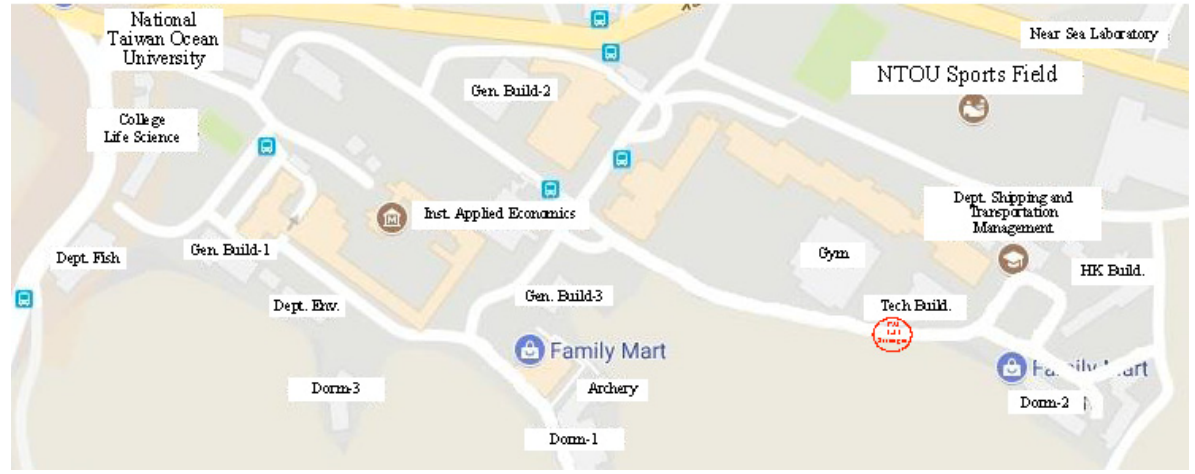
Figure 34. The location of the stranger being indicated on the map in real-time (WGS84: N25.14993733502751,